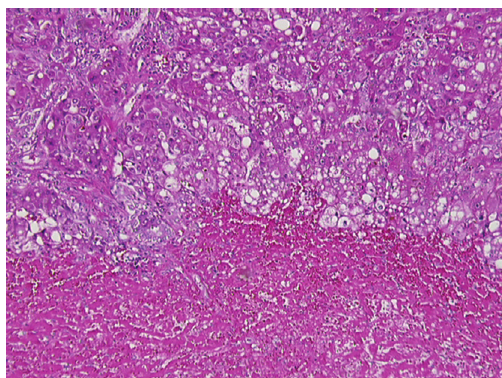
Figure 3: Native liver (100x, H&E section): higher power view of the interface in the native liver between viable and necrotic hepatic tissue. Note the cytologic changes of hepatocellular injury in the viable